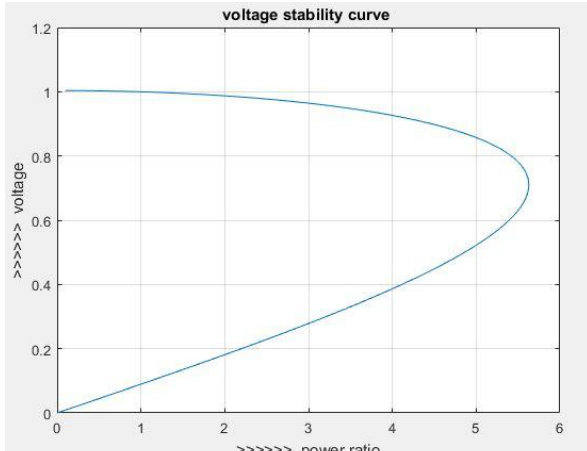
- P /P characteristics for without m R o